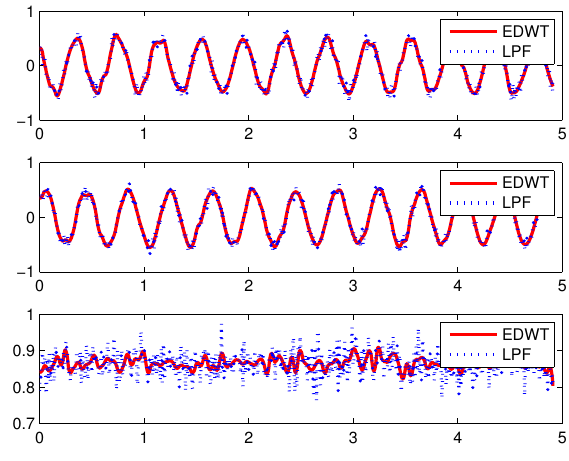
Figure 5. Filtered components based on